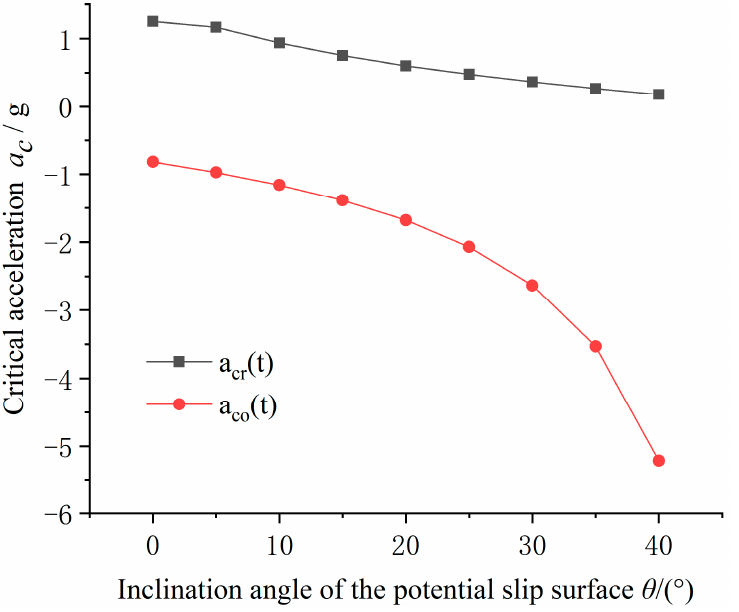
Figure 8. Influence of inclination angle of potential slip surface θ on critical acceleration a c.